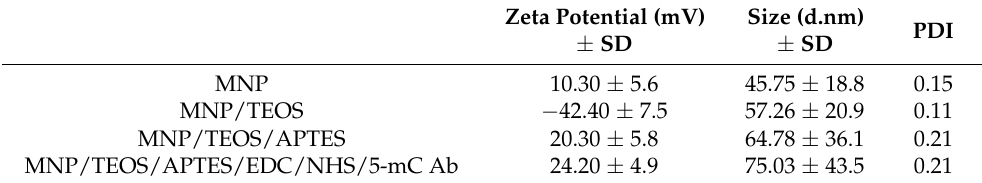
Table 1. Zeta potential and size measurement results for each modification steps of